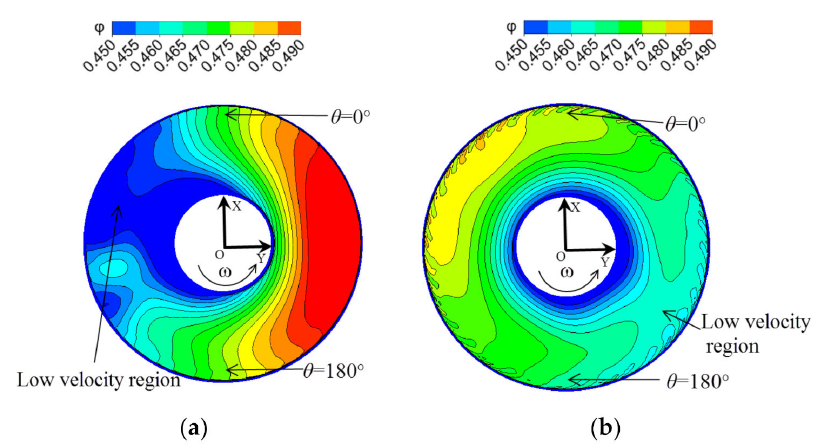
Figure 12. Distribution of inlet flow coe ffi cient near stall in the case of E = 160%. ( a ) Steady CFD result; ( b ) unsteady CFD result.